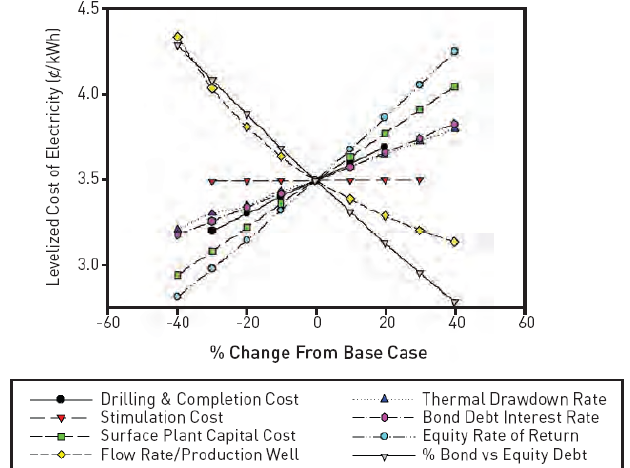
Figure 74. Influencing factors for levelised cost of geothermal electricity. © 2006 MIT, reproduced from [302] with